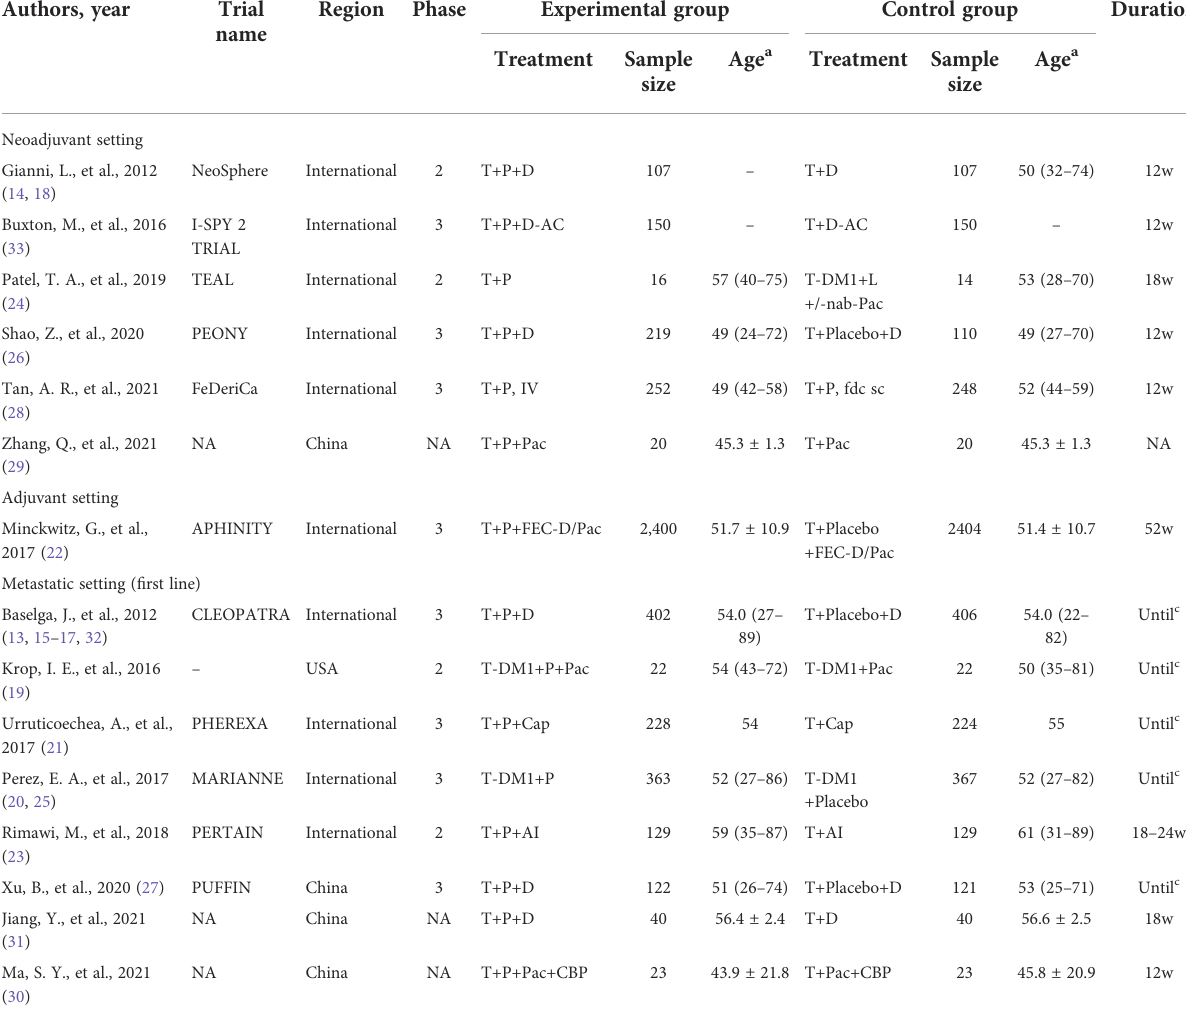
TABLE 1 Characteristics of the included